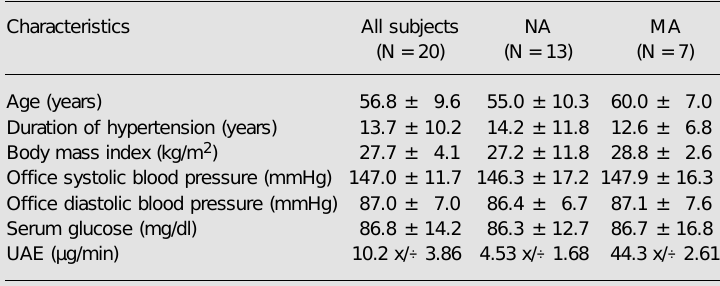
Table 1. Clinical characteristics of the normoalbuminuric (NA) and the microalbuminuric (MA) patients.